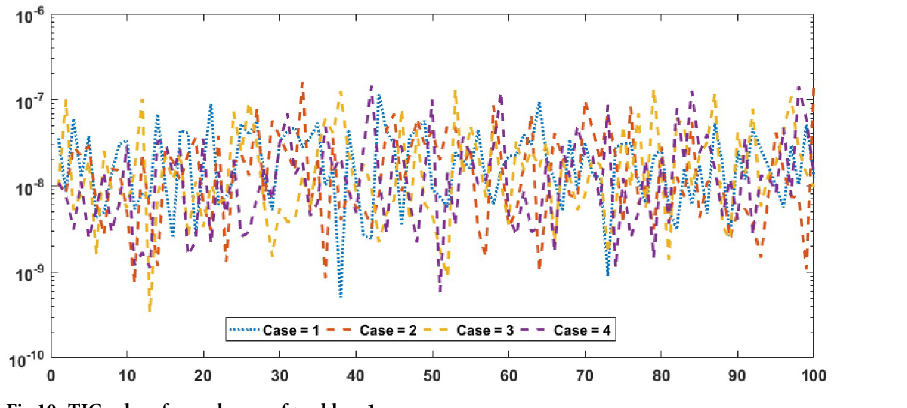
Fig 10. TIC values for each case of problem 1.